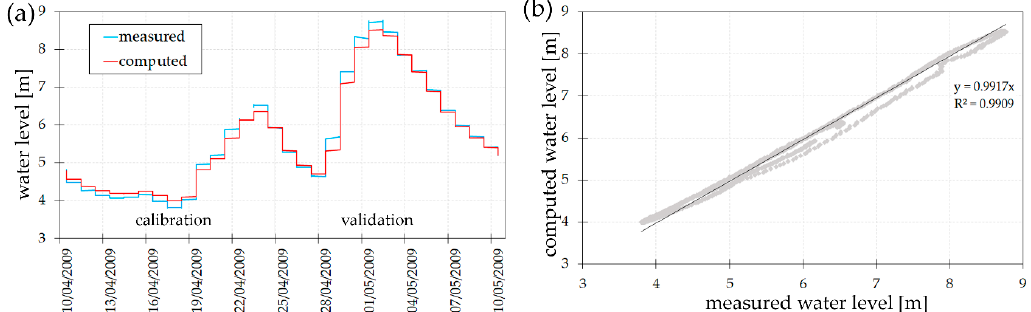
Figure 3. Calibration and validation of the model at the Polesella gauging station: ( a ) comparison between measured (blue line) and computed (red line) water levels; ( b ) computed ( y -axis) and measured ( x -axis) water levels during the study period.